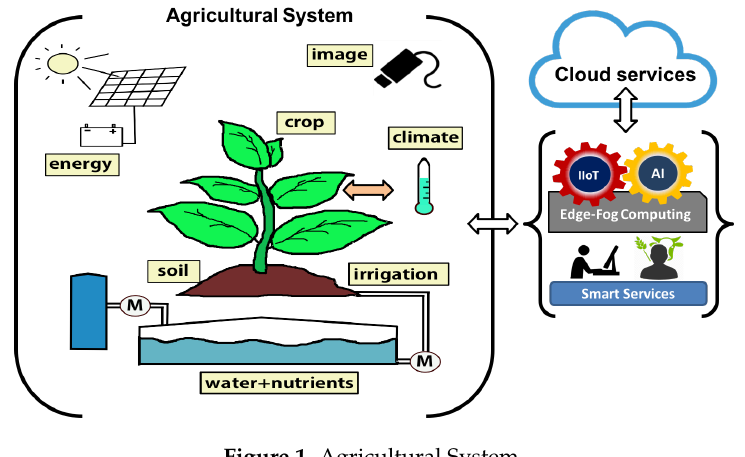
Figure 1. Agricultural